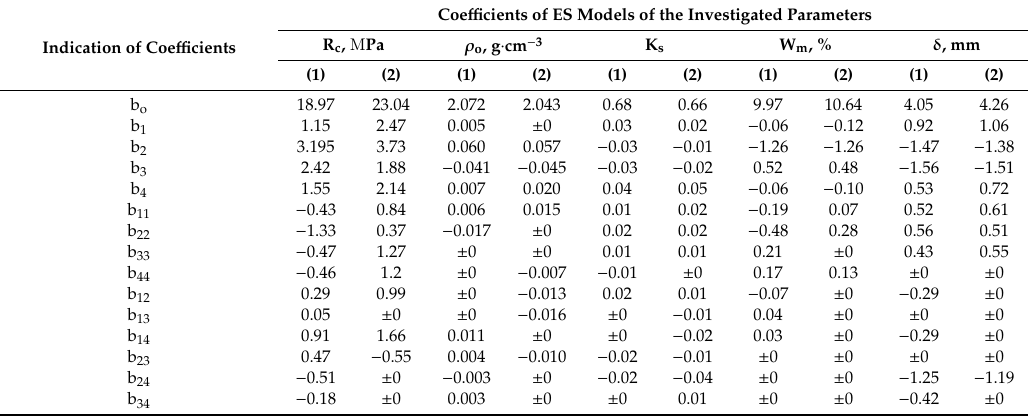
Table 5. Correlation coe ffi cients of ES models of changes in basic properties of testing samples obtained by dynamic (1) and static (2) carbonation